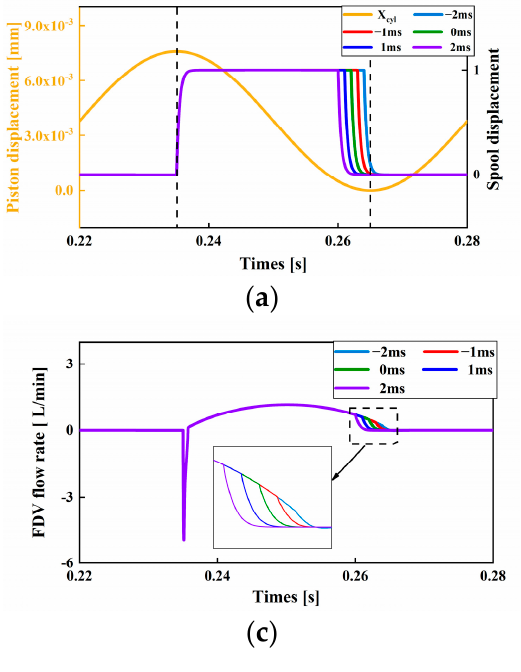
Figure 6. C haracteristics with different 𝑇 (cid:3030)(cid:3030) : ( a ) spool displacement; ( b ) piston chamber pressure; ( c ) Figure 6. Characteristics with different T cc : ( a ) spool displacement; ( b ) piston chamber pressure; FDV flow rate; ( d ) auxiliary check valve flow rate. ( c ) FDV flow rate; ( d ) auxiliary check valve flow